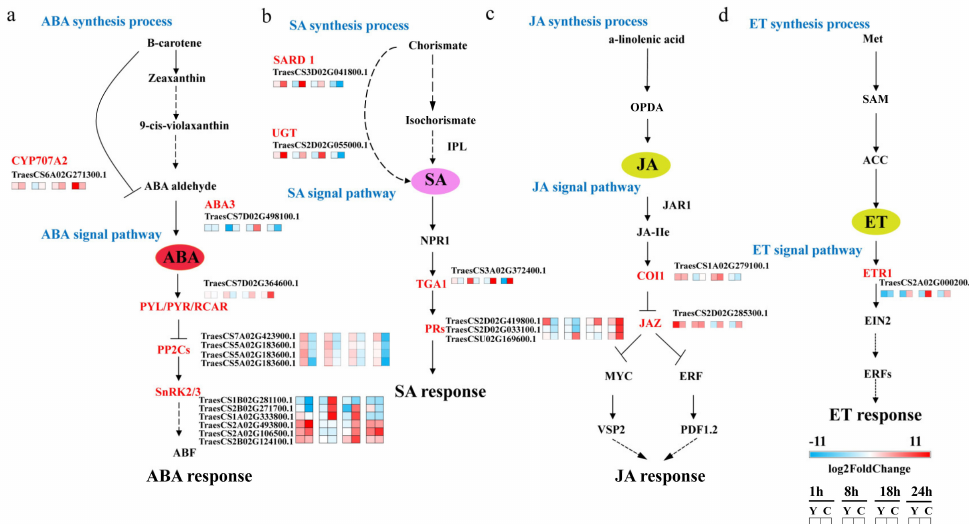
Figure 4. Di ff erentially expressed genes related to plant hormone pathways in CMPG1-V OE and susceptible receptor Yangmai 158 from 1 hai to 24 hai by Bgt infection. ( a ) ABA pathway; ( b ) SA pathway; ( c ) JA pathway; ( d ) ET pathway. Heat map showing the gene expression. The colors blue, white, and red represent low, medium, and high expression levels, respectively. Y represents Yangmai 158, C represents CMPG1-V OE . Genes with the regulation ratio log ≥ 2 or ≤− 2 were selected.